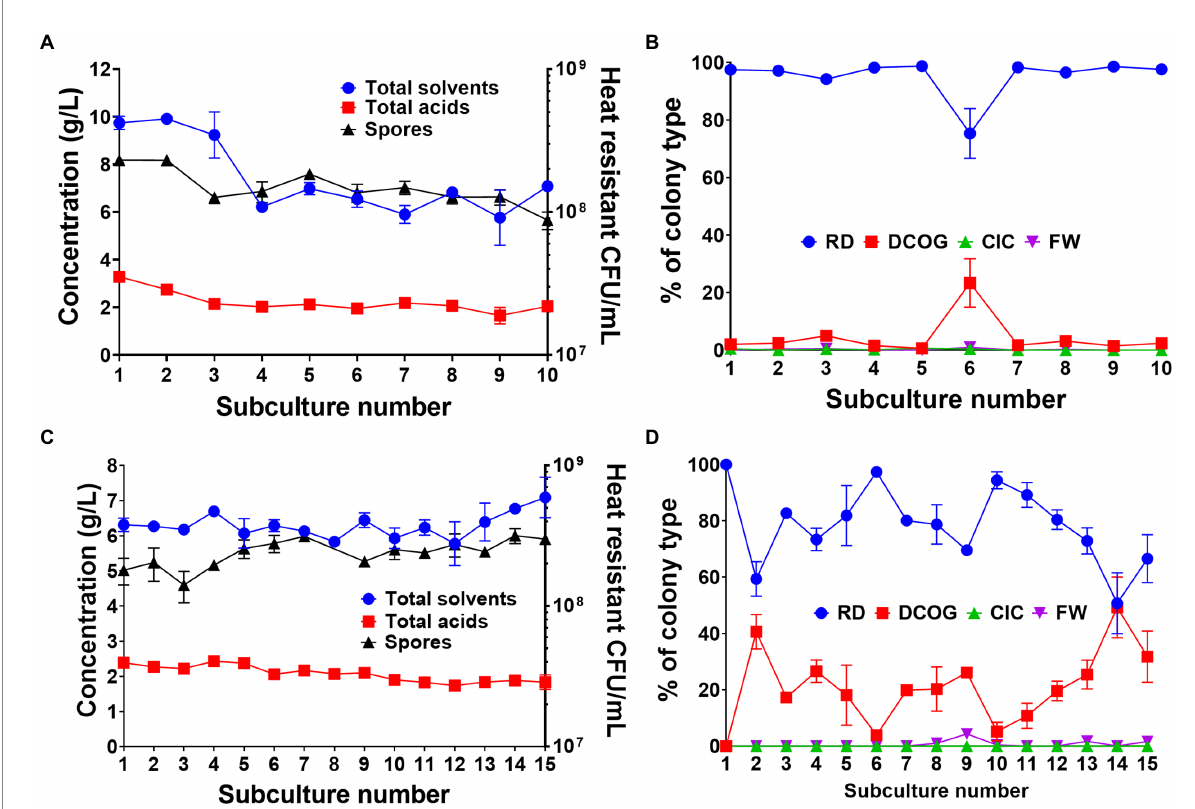
FIGURE 5 Effects of 72 h transfer time (A,B) and applying a heat shock bottleneck before subculturing (C,D) on culture productivity, spore formation and colony morphotype dynamics. (A) Concentration of fermentation products (combined solvents: acetone, ethanol, butanol, combined acids: acetate and butyrate) and number of heat resistant spores produced by the whole culture at each successive 72 h subculture. (B) Percentage of each colony type found during the 72 h subculturing. (C) Concentration of fermentation products (combined solvents: acetone, ethanol, butanol, combined acids: acetate and butyrate) and number of heat resistant spores produced by the whole culture at when a heat shock is applied before inoculation of each subculture. (D) Percentage of each colony type found when a heat shock is applied at each subculture. Values are the means (± SEM) of the biological replicates. n = 5 for the 72 h transfer and n = 3 for the heat shock